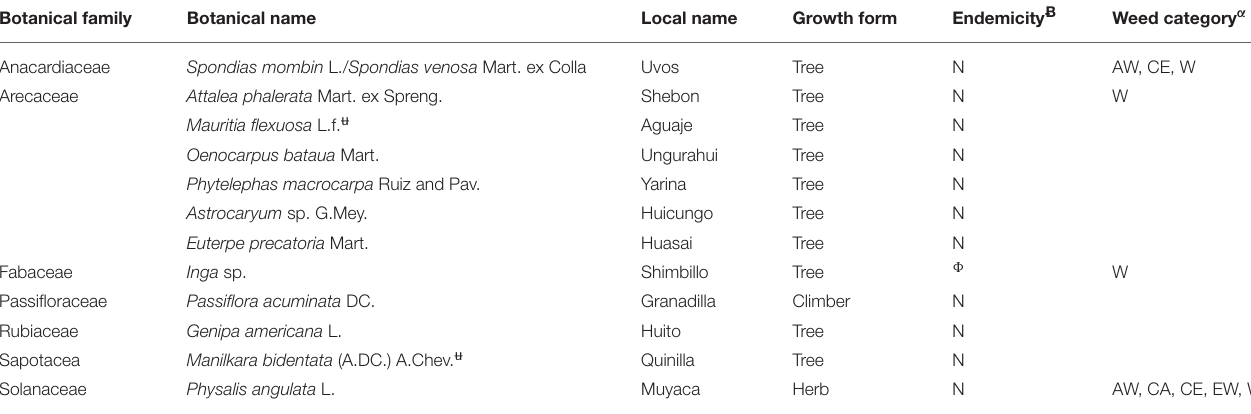
TABLE 2 | List of “wild” food plant species that are not transplanted indicating botanical name, local name, growth form, endemicity, and weed category ( n =